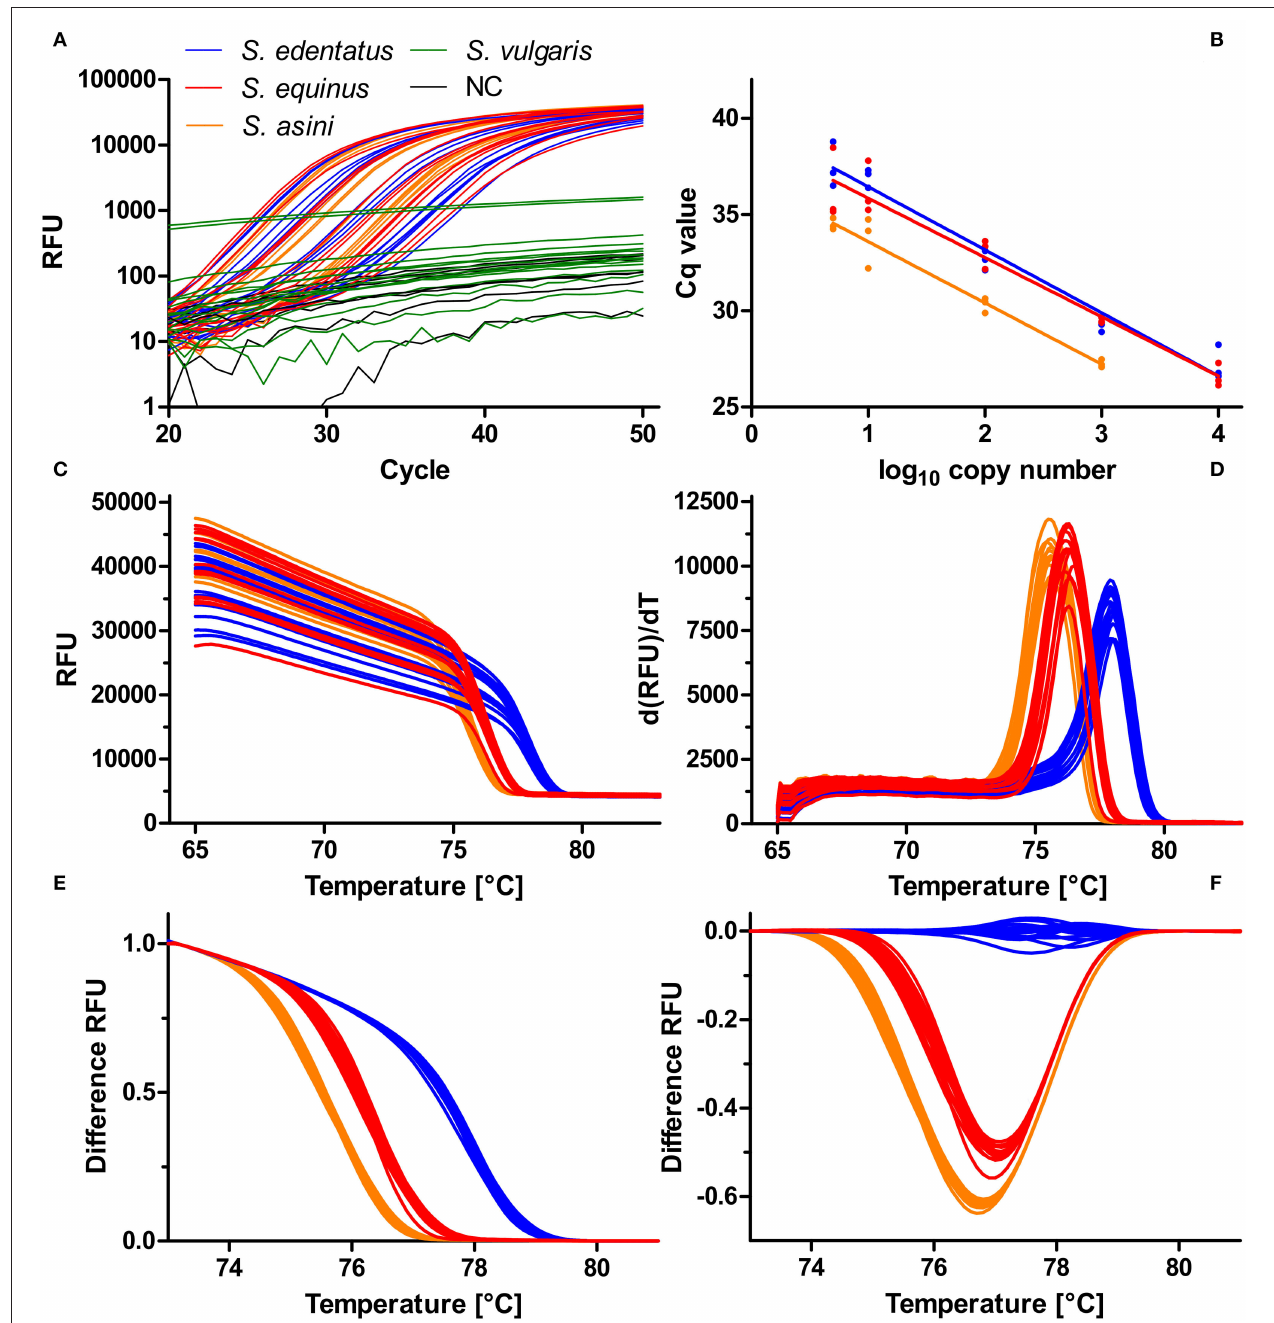
FIGURE 3 | Establishment of a high-resolution melt PCR to distinguish Strongylus edentatus , Strongylus equinus, and Strongylus asini . PCR. The amplification plots show that presence of 10,000–5 copies ( S. edentatus , S. equinus ) or 1,000–5 copies ( S. asini ) ITS-2 plasmid resulted exponential amplification while there was no exponential increase of relative fluorescence units (RFU) in the presence of 10,000 to 5 copies of S. vulgaris ITS-2 DNA or in the absence of any template (NC). (A) . Using the data from (A) , the quantification cycles (Cq) were plotted against the log 10 transformed copy numbers and linear regressions were calculated (B) . There were no significant differences between slopes ( p = 0.760). Raw melting curves (C) and their first derivative dRFU/dT (D) were recorded between 65 ◦ C and 98 ◦ C. Normalisation of the melting curves between 73.1 and 79.9 ◦ C resulted in clear separation of the melting curves (E) , which was also visible in the difference plot (F) , in which the mean normalised fluorescence for S. edentatus was subtracted from all individual